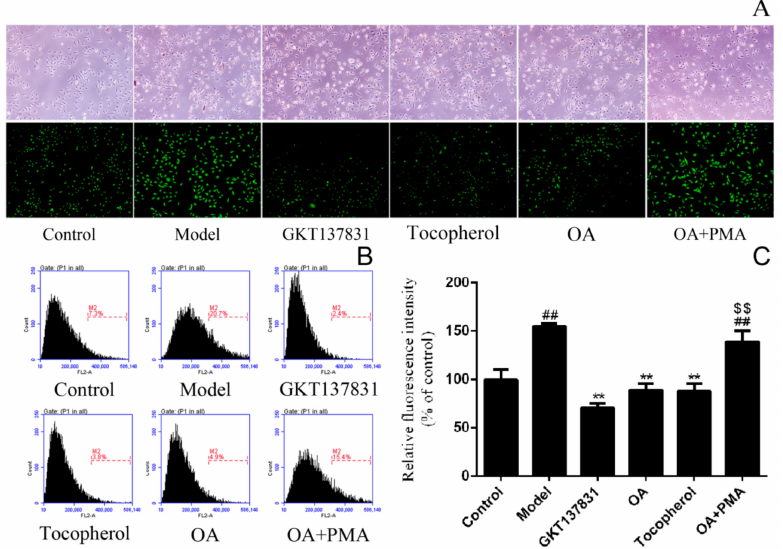
Figure 3. Obcordata A (OA) inhibits the intracellular reactive oxygen species (ROS) production. ( A ) The dichlorodihydrofluorescein diacetate (DCFH-DA) assay was performed to detect cellular ROS levels. Cell morphology and fluorescence intensity were observed and recorded using a microscope (original magnification, × 400). In the model group, the cells shrunk, the transmittance increased, and calcium oxalate crystals were observed on the cells and in the medium. In fluorescence mode, stronger fluorescence intensity means higher intracellular ROS levels. OA can reduce the fluorescence intensity of model cells, which can be eliminated by phorbol-12-myristate-13-acetate (PMA). ( B ) DCFH-DA staining in HK-2 cells was detected by flow cytometry. ( C ) Statistical results of relative fluorescence intensity. The mean fluorescence intensity of the cells in the model group was significantly increased, and OA, GKT137831, and tocopherol reduced the fluorescence intensity of the cells. When OA and PMA are added at the same time, the fluorescence intensity of the cells is not lowered. n = 3 independent experiments. ## P < 0.01 versus control group; ** P < 0.01 versus model group; $$ P < 0.01 versus OA group.